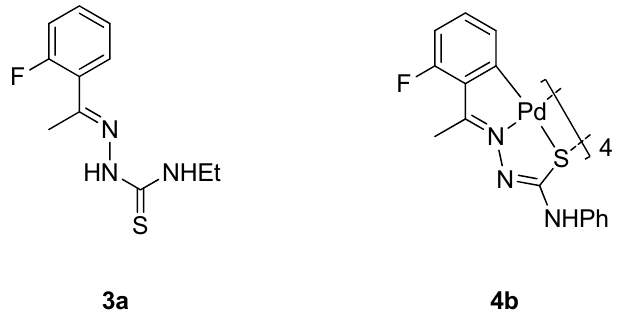
Scheme 2. Compounds 3a and 4b were studied by X-ray diffraction study.